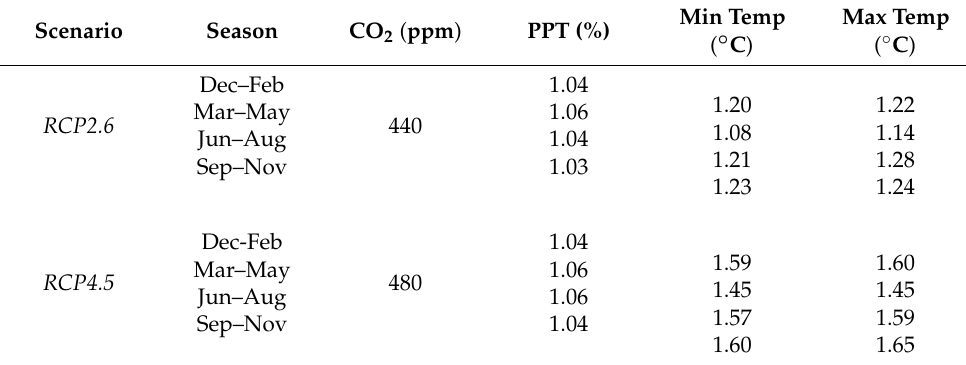
Table 1. Climate change scenarios. Comparisons of seasonal changes in CO 2 , precipitation (PPT), and minimum (Min) and maximum (Max) temperature (Temp) were considered under four different RCP pathways (RCP2.6, RCP4.5, RCP6.5, and RCP8.5) between the baseline in the 2010s (from 1986 to 2015) and 2050s (2036 to 2065). These data were obtained from KNMI Climate Explorer